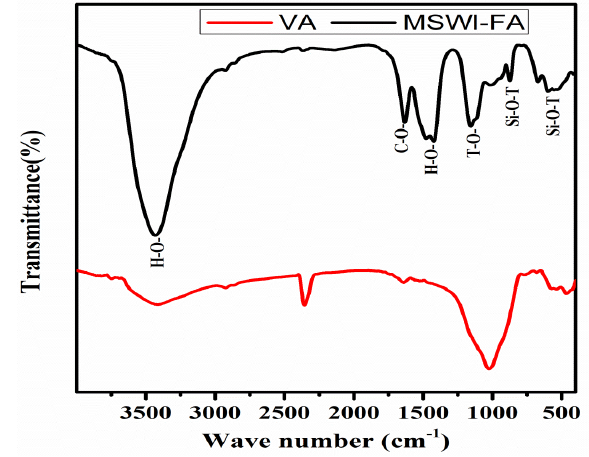
Figure 2. FTIR spectrum of MSWI-FA and VA.